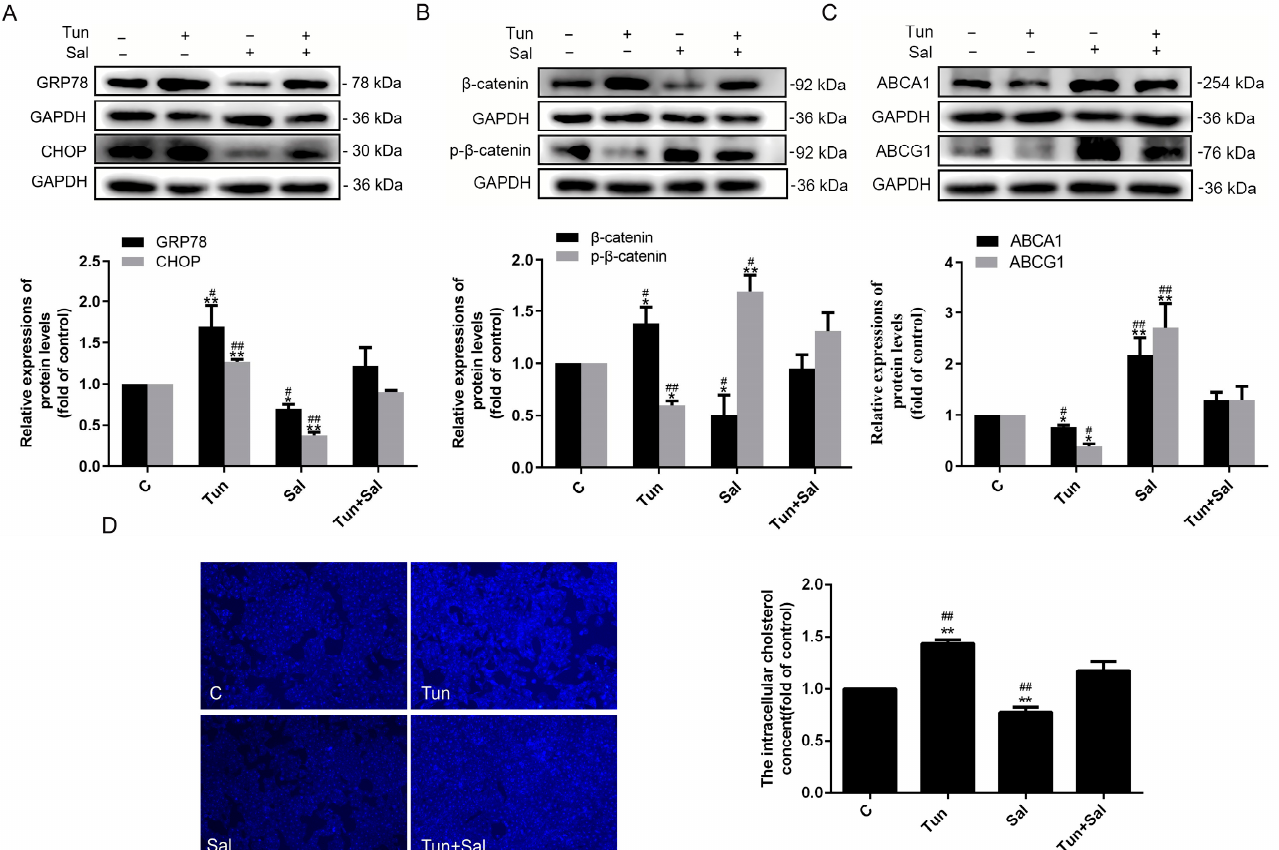
Figure 6. Activating ER stress can increase the accumulation of cholesterol and activate Wnt/ β - catenin pathway, and inhibition of the Wnt/ β -catenin pathway can attenuate the accumulation of cholesterol and ER stress. ( A – C ) The expressions of GRP78, CHOP, β -catenin, p- β -catenin ABCA1, and ABCG1 were detected by Western blot. ( D ) Filipin staining detected the intracellular cholesterol of HUVECs (magnification 5 × ). n = 3, * p < 0.05 and ** p < 0.001 vs. the C group; # p < 0.05 and ## p < 0.001 vs. the Tun + Sal group. C, control group (treated by DMSO); Tun, cells treated with tunicamycin (10 µ mol/L) for 24 h; Sal, cells treated with salinomycin (5 µ mol/L) for 24 h; Tun + Sal, cells treated with tunicamycin (10 µ mol/L) for 2 h, and then salinomycin (5 µ mol/L) were used to treat cells for 22 h. The scale of the images is 100 µ